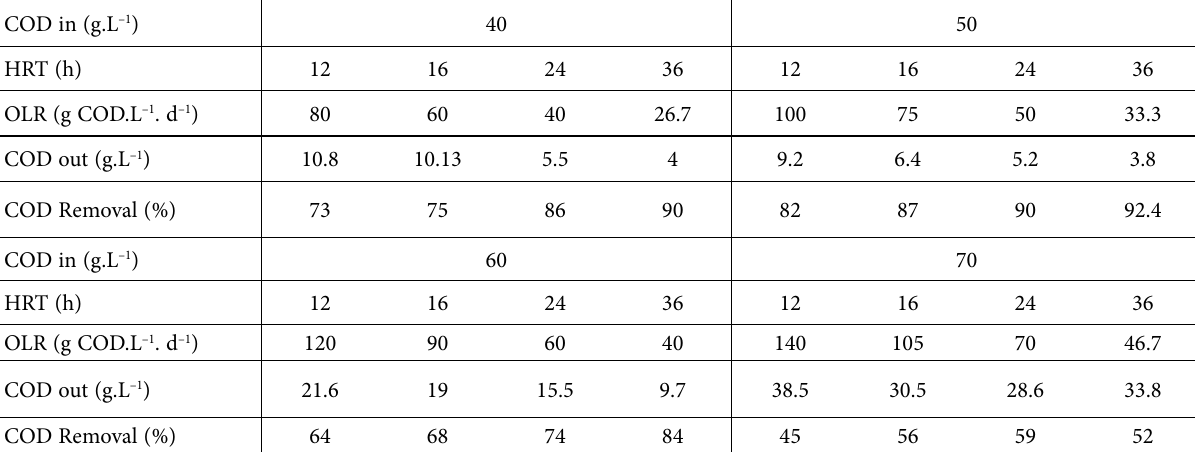
Table 1. The COD variations and COD removal in certain OLRs and HRTs COD in (g.L –1 )